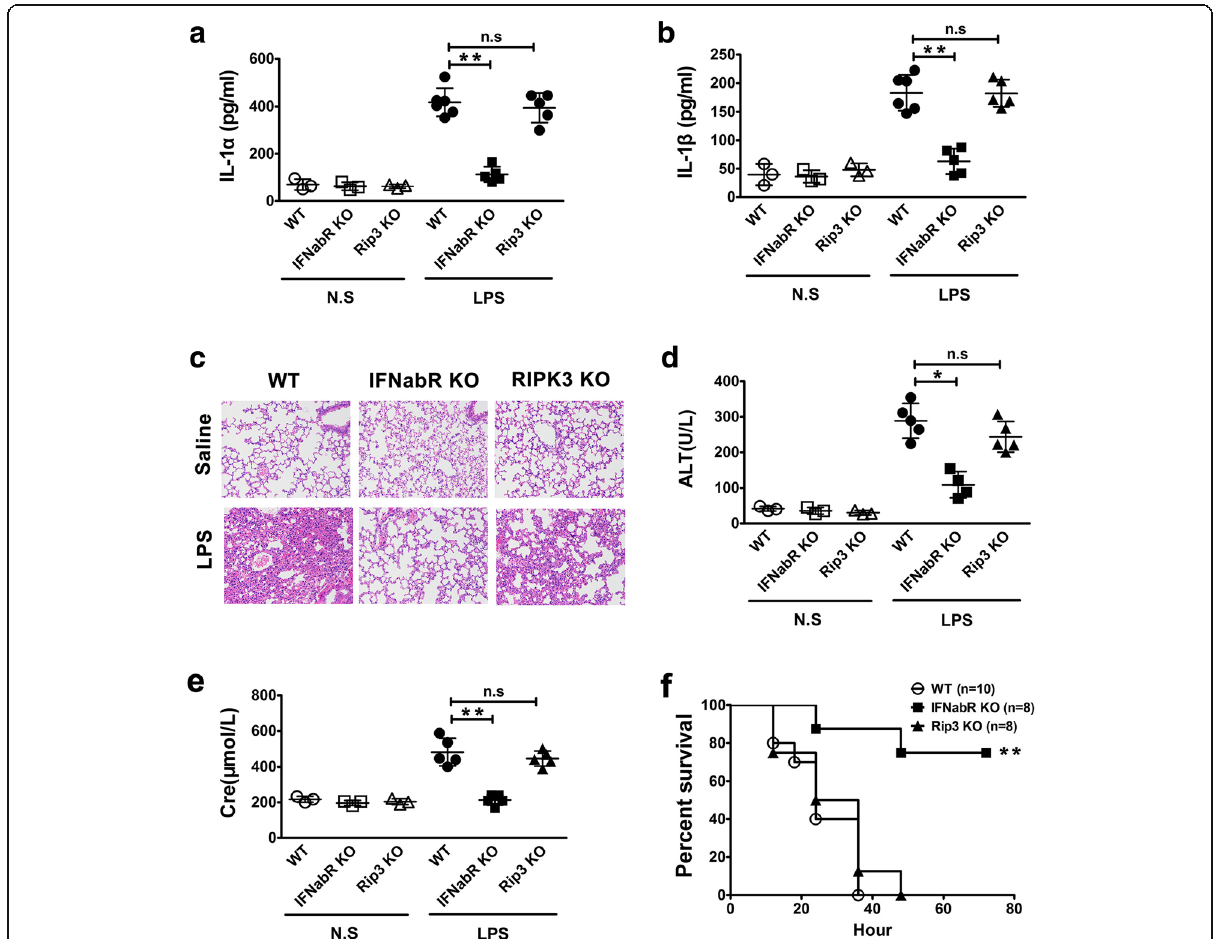
Fig. 4 Type 1 interferon signaling is critical for caspase-11-dependent immune responses, organ injury and lethality in endotoxemia. a-b Serum IL-1 α and IL-1 β levels from mice of indicated genotypes following intraperitoneal injection with either 10 mg/kg LPS or saline. c H&E staining of the lungs from mice of indicated genotypes ( n = 5) following intraperitoneal injection with either 10 mg/kg LPS or saline. d-e The serum alanine aminotransferase (ALT) and creatinine (Cre) levels from mice of indicated genotypes following intraperitoneal injection with either 10 mg/kg LPS or saline. f Kaplan Meier survival curves for the indicated genotypes following intraperitoneal injection with 40 mg/kg LPS. * P